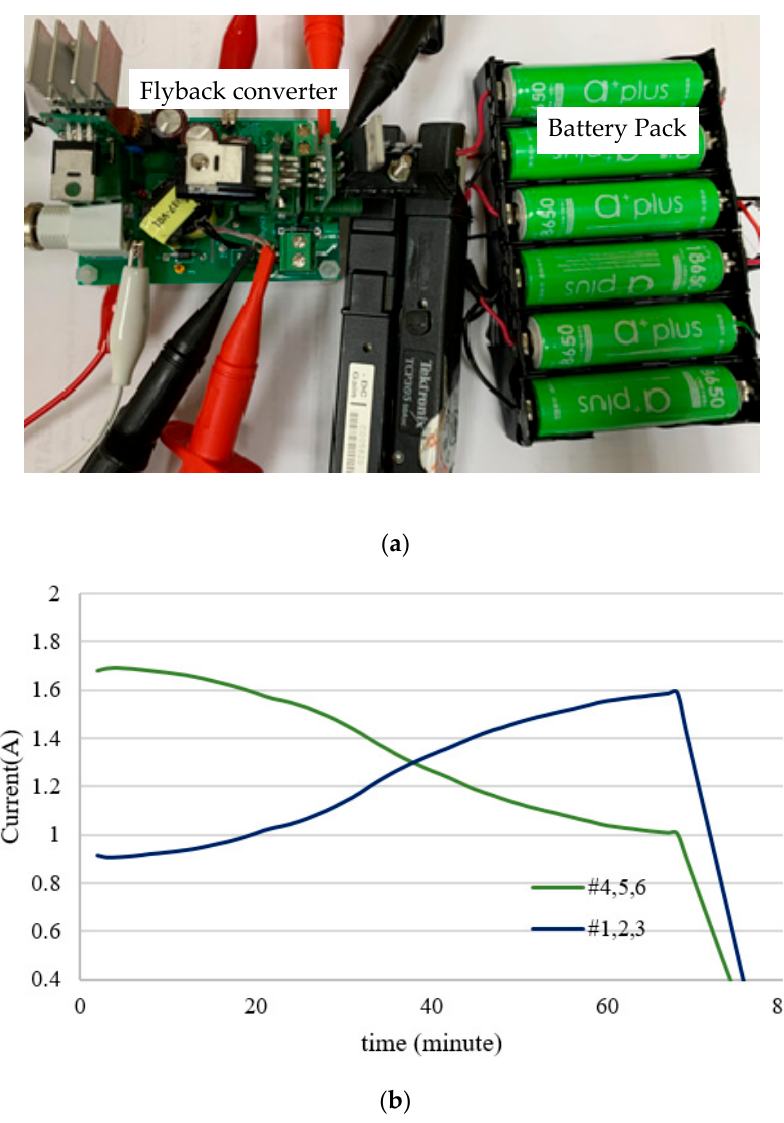
Figure 12. Parallel lithium battery charging experiment: ( a ) experimental setting and ( b ) 1.3 A current response.